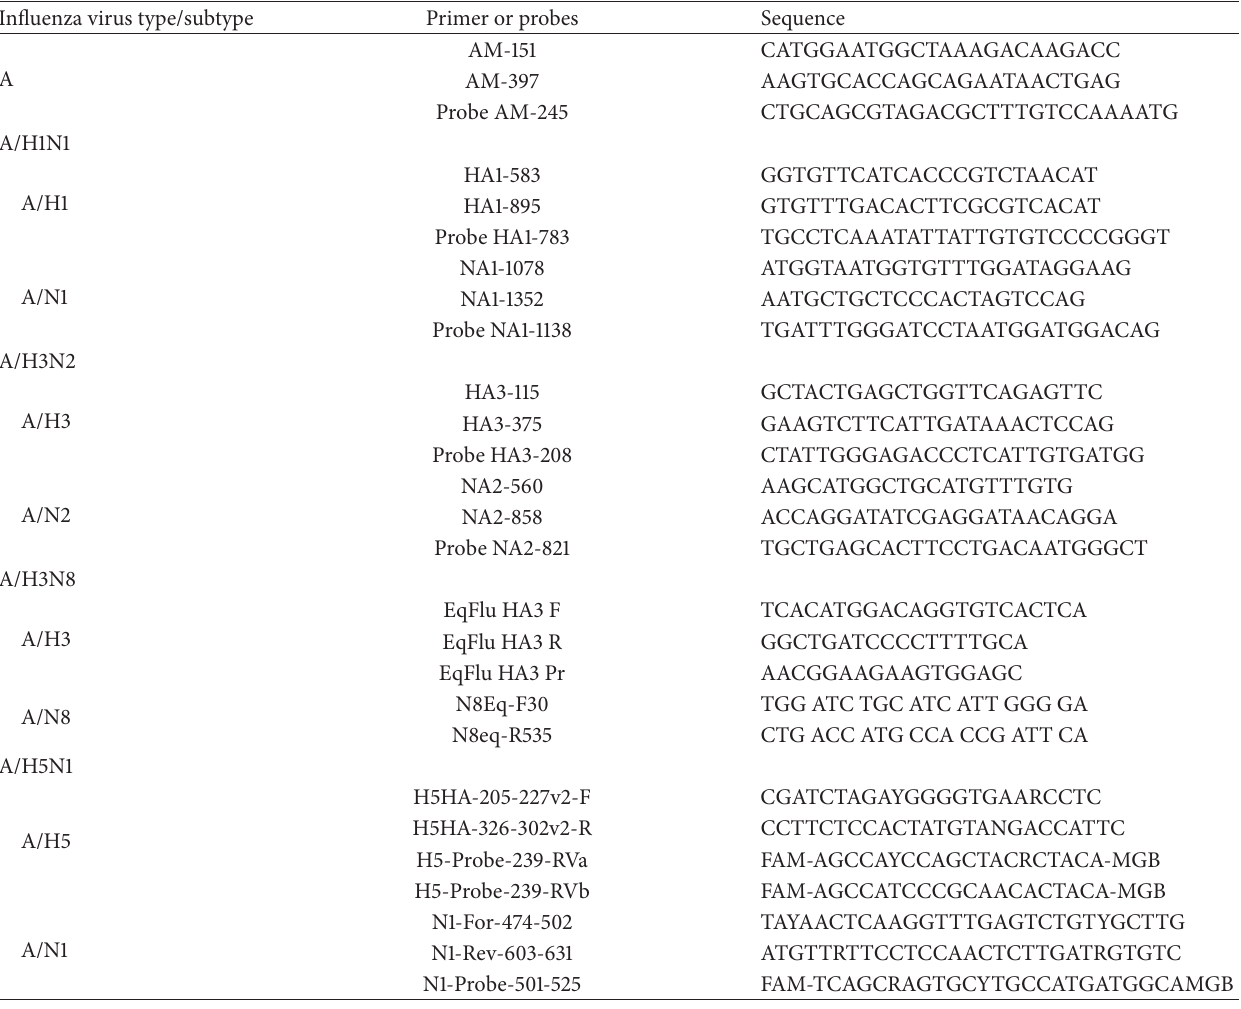
Table 2: Oligonucleotide primers and probes for influenza A virus typing and subtyping in real-time PCR and RT-PCR.